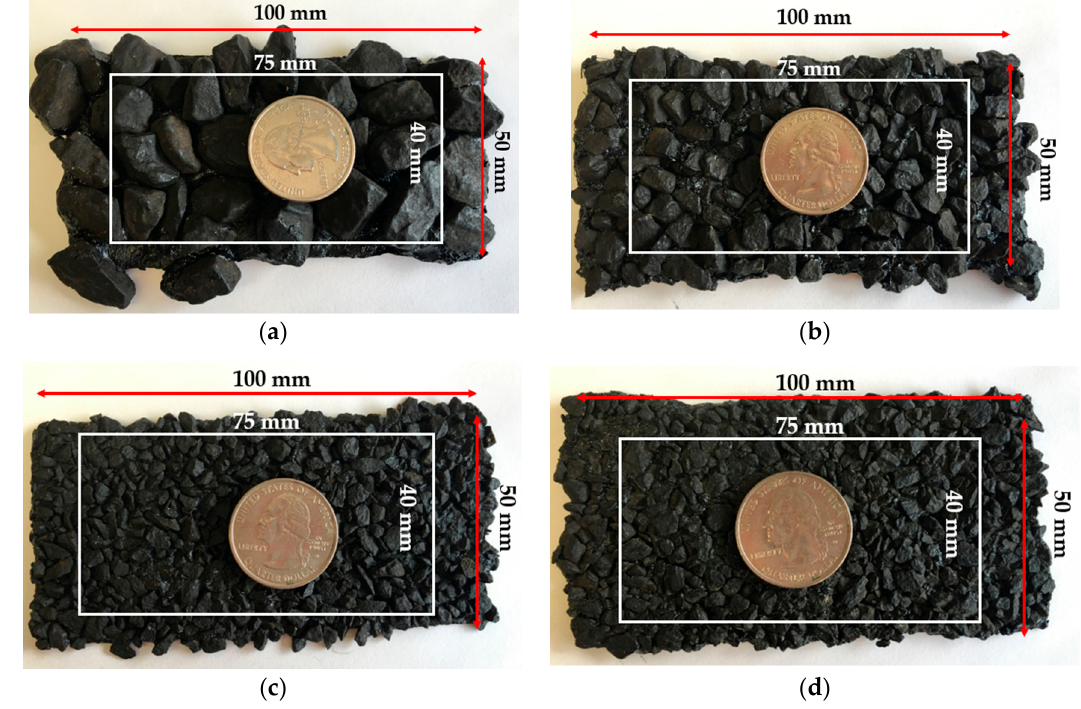
Figure 3. Pavement samples used for scan, ( a–d ) for samples 1 – 4.